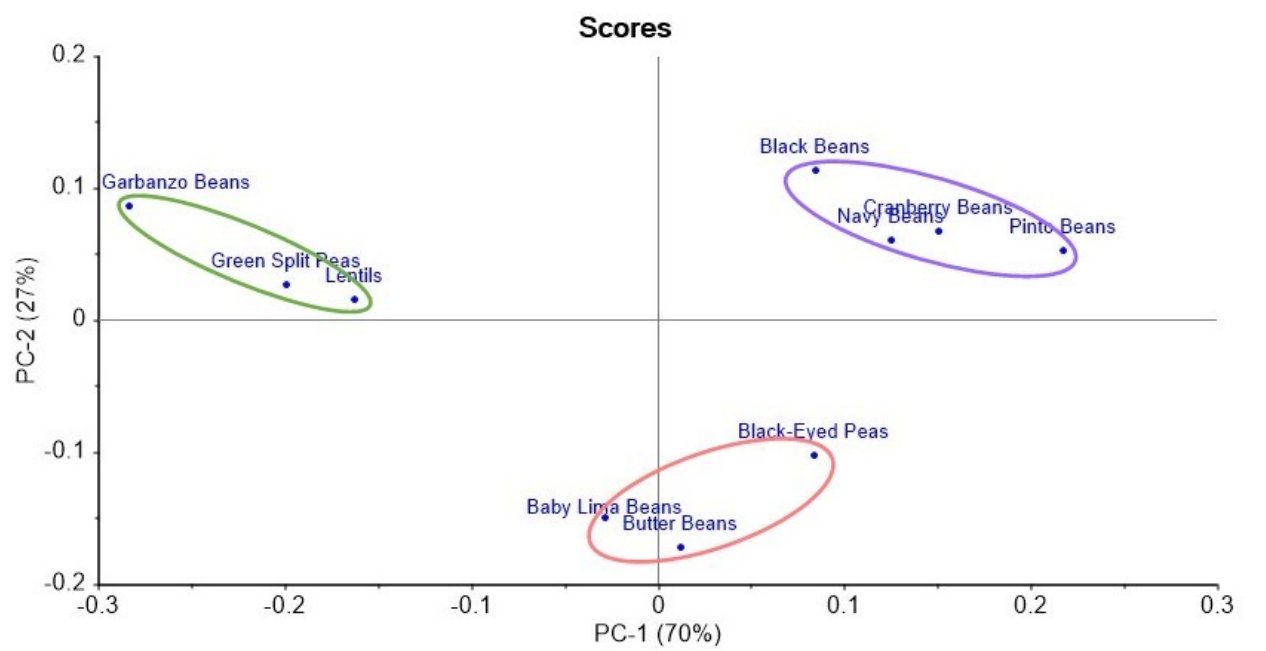
Figure 2. Scores plot from Principal Component Analysis of the complete FA compositions by C:U of the ten pulse samples. Ovals added to highlight clusters.